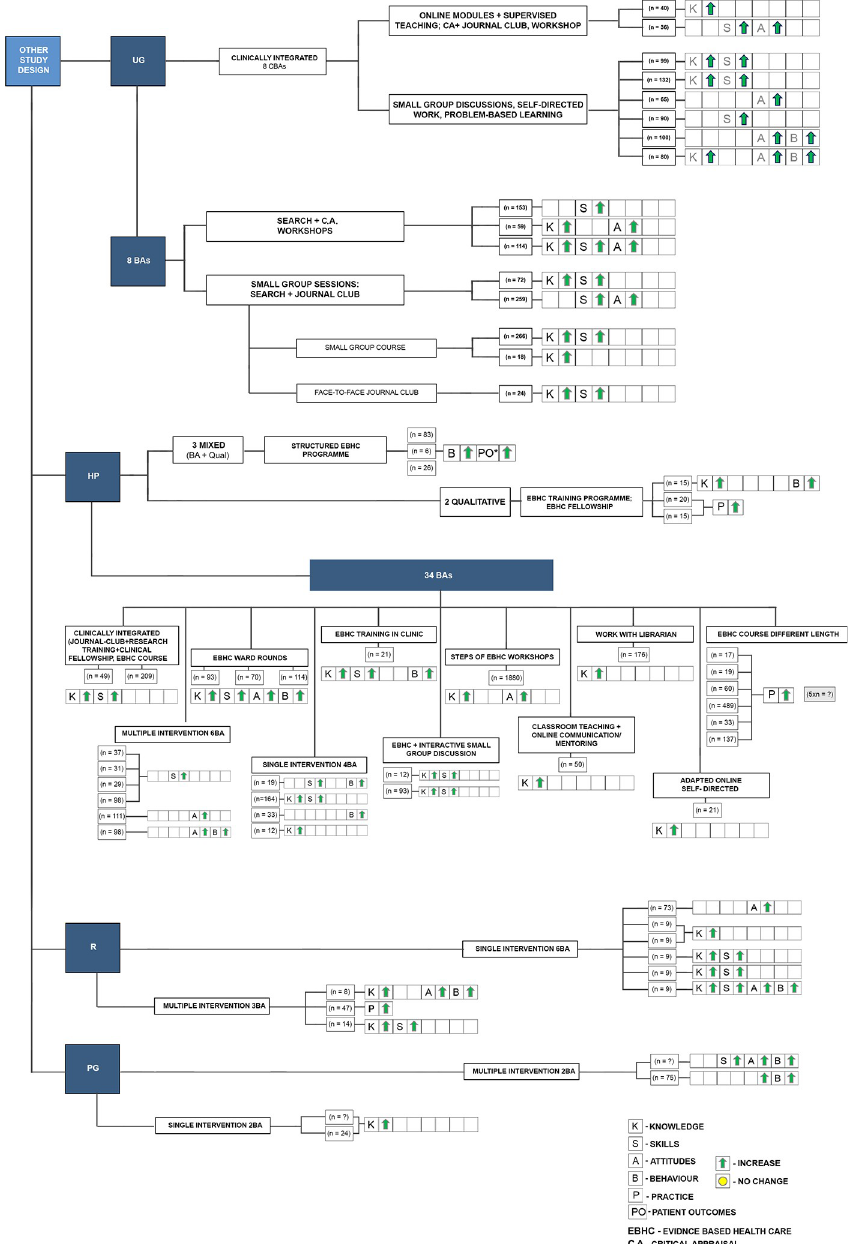
Fig 6. Illustrative display of the likely impact of different teaching approaches at different medical education levels–summary from other study designs (i.e., before-after, qualitative studies). BA–before and after study, CBA– controlled before and after study, HP–health professionals, R–residents, UG–undergraduates; Explanation of the coloured symbols used are provided on the